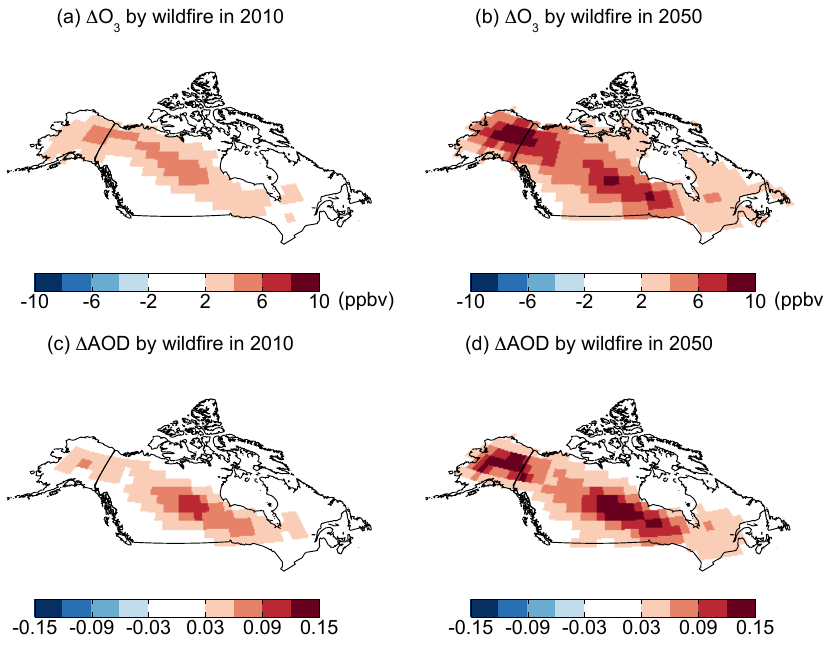
Figure 6. Changes in summer (a, b) [O 3 ] and (c, d) AOD at 550 nm induced by wildfire emissions in (a, c) the 2010s and (b, d) the 2050s over boreal North America. Only significant changes ( p < 0 . 05) are